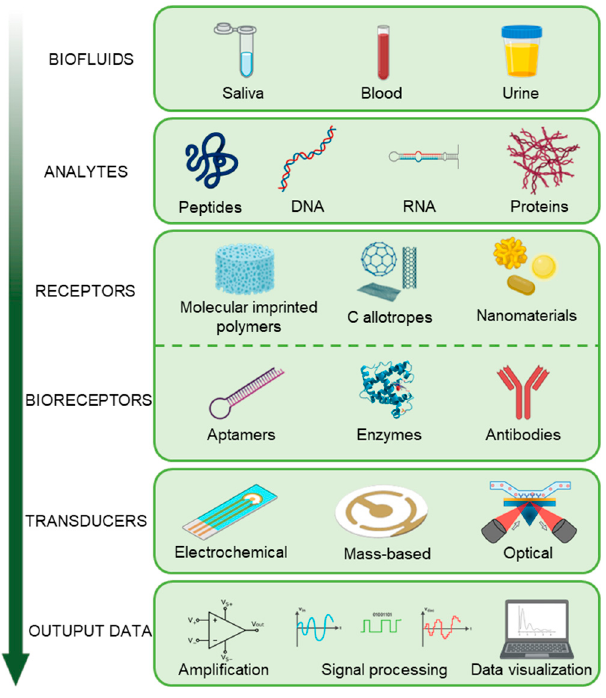
Figure 4. Components of a biosensor and its working principle.